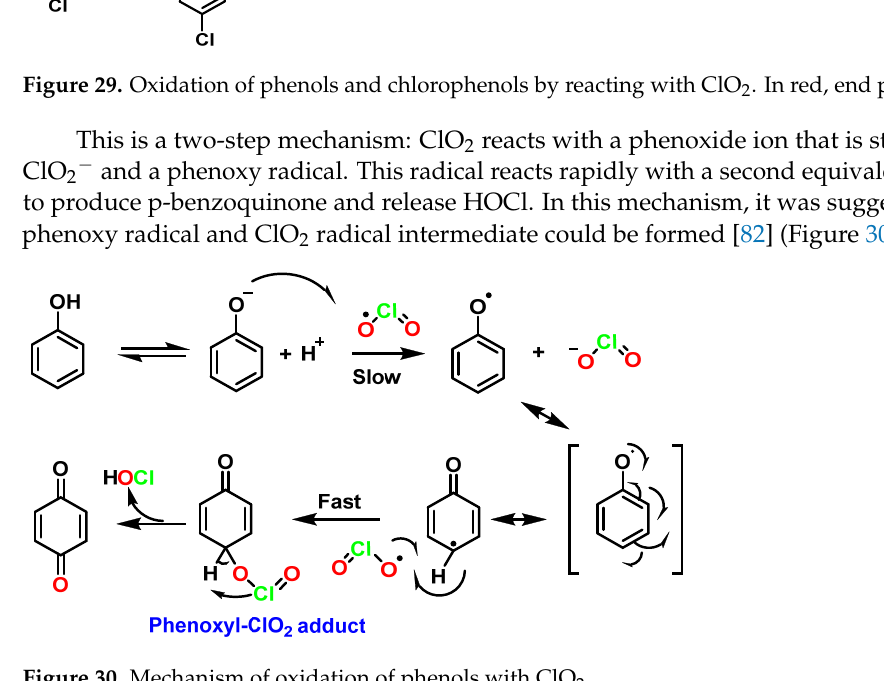
Figure 30. Mechanism of oxidation of phenols with ClO 2 . Chlorinated derivatives in the oxidations of phenols with ClO 2 can be explained by the hypochlorous acid formed in the reaction [83] (Figure 31).